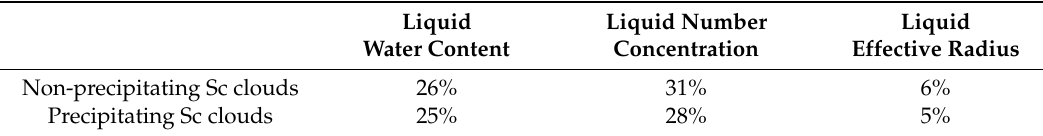
Table 1. The mean fractional uncertainties in the 2B-CWC-RVOD retrieved PS and NPS clouds microphysical properties including the liquid water content, liquid number concentration and liquid effective radius. The uncertainties are expressed in percent and are rounded to the nearest